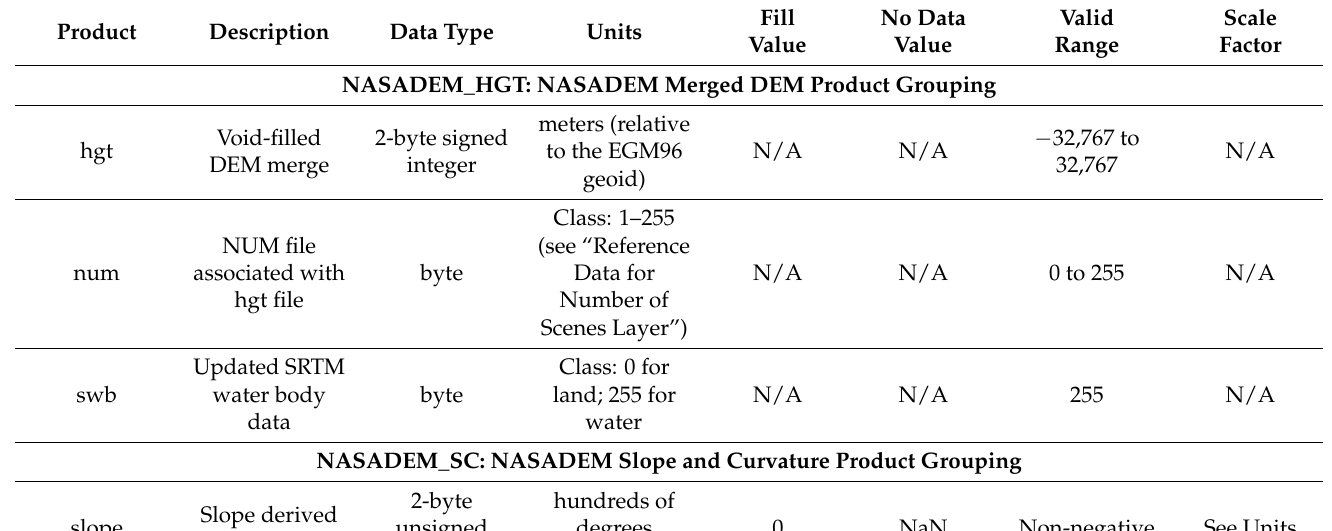
Table 2. NASADEM products and their